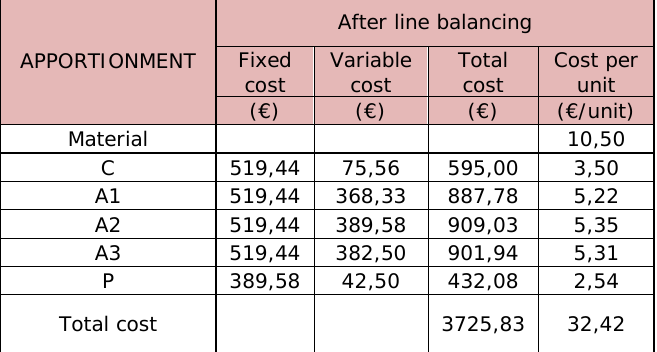
Table 11. “Calculation of the production cost when apportionment is